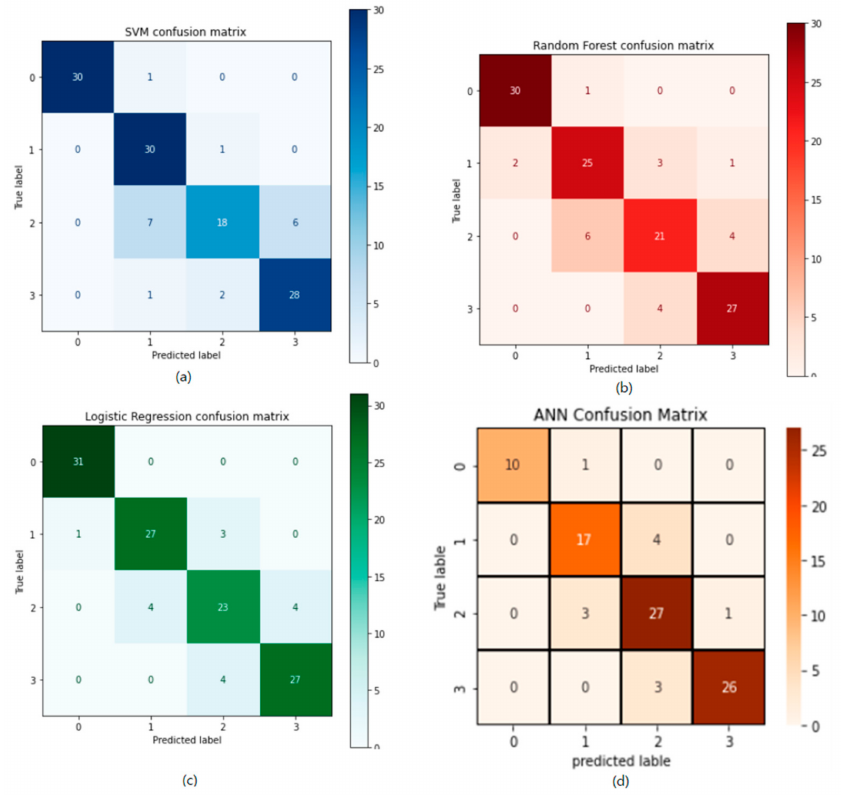
Figure 4. ( a ) is confusion matrix of SVM, ( b ) is confusion matrix of RF, ( c ) is confusion matrix of LR and ( d ) is confusion matrix of